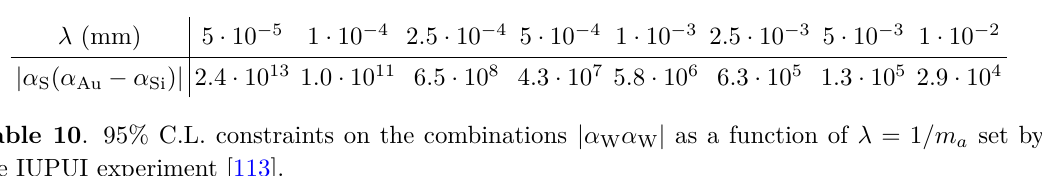
Table 9 . 95% C.L. constraints on the combinations | α I α J | as a function of λ = 1 /m a set by the Stanford experiment [112].